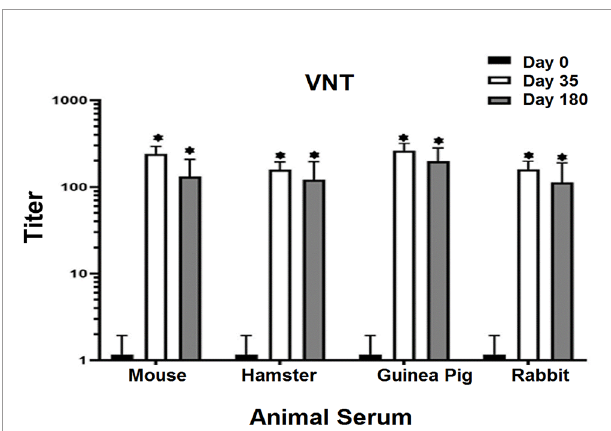
FIGURE 6 | Virus Neutralizing Test (VNT) in vaccinated animals with middle doseofcandidatevaccine. VNThasbeendoneinVerocelllines. Allthevaccinated animalswith middledose of candidate vaccine were able to activate neutralizing antibodies after 14 days of the fi rst vaccinebooster.Excellent neutralizingtiters of mice, hamsters, guinea pigs, and rabbits were observed in sera from the immunized animals on day 35 and 180 that showed signi fi cant difference with zero day. The seroconversion assay showed neutralizing antibodies on days 35 and 180 in 80 to 90% of the vaccinated animals. The control and placebo groups showed no ability to neutralize the virus. p values lower that 0.05 were considered to be statistically signi fi cant (*p<0.05). Data are presented as mean± SD. The levels of statistical signi fi cance for differences between test groups were determined using one-way ANOVA followed by Tukey ’ s post hoc test. Statistical comparison was done by comparing the vaccinated group on days 0 with days of 35 and